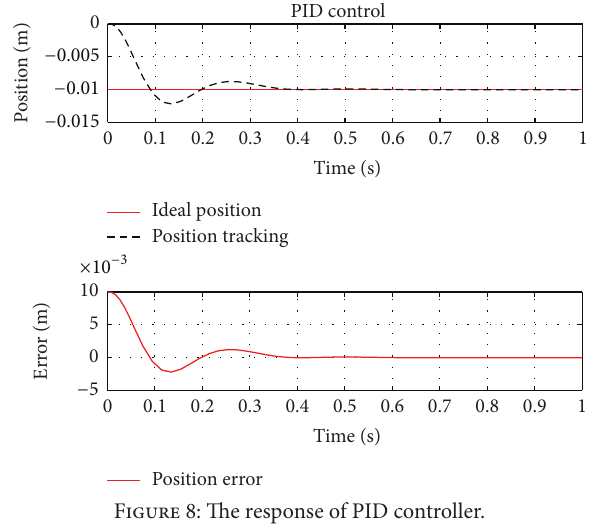
Figure 8: The response of PID